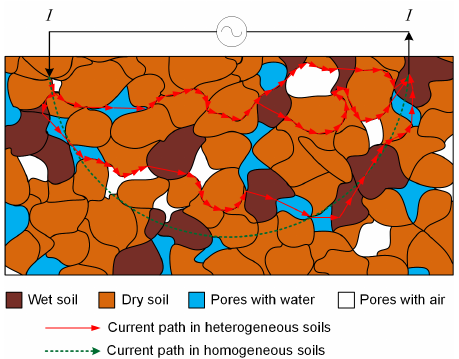
Figure 3. Preferential path of electrical current in homogeneous and heterogeneous